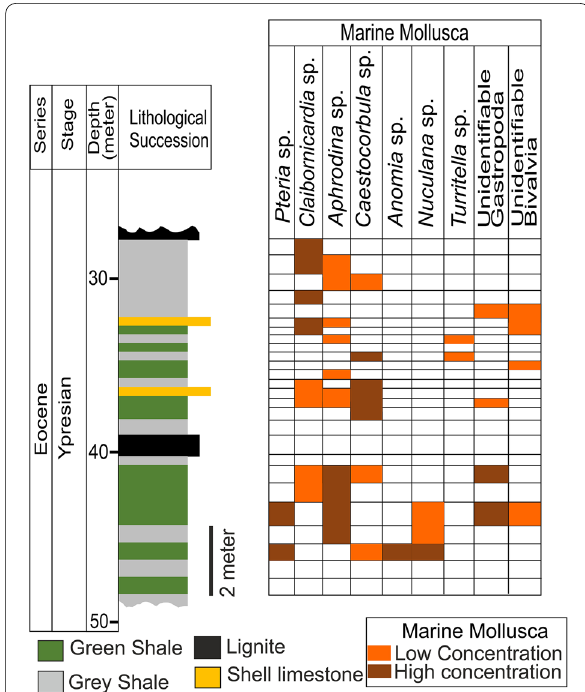
Fig. 4 Relative abundance of mollusc fossils in different layers shown along with the lithostratigraphic column of unit